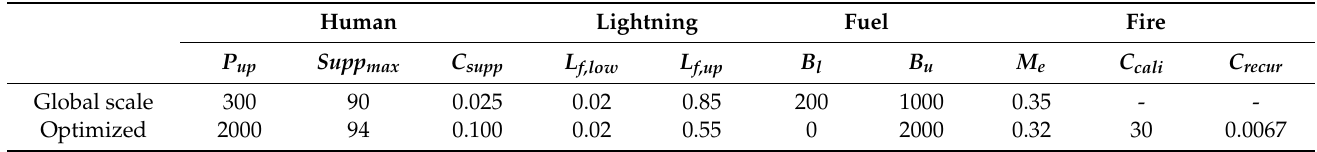
Table 1. FLAM parameters optimized in South